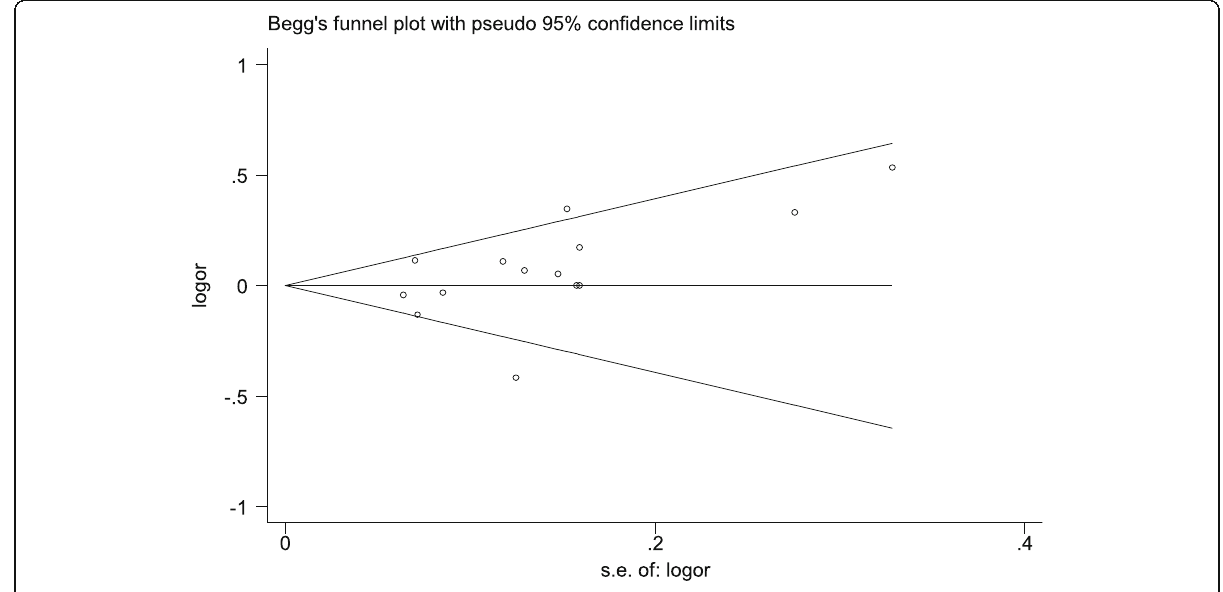
Fig. 5 Begg ’ s funnel plot. The funnel plot suggested no publication bias among the eligible